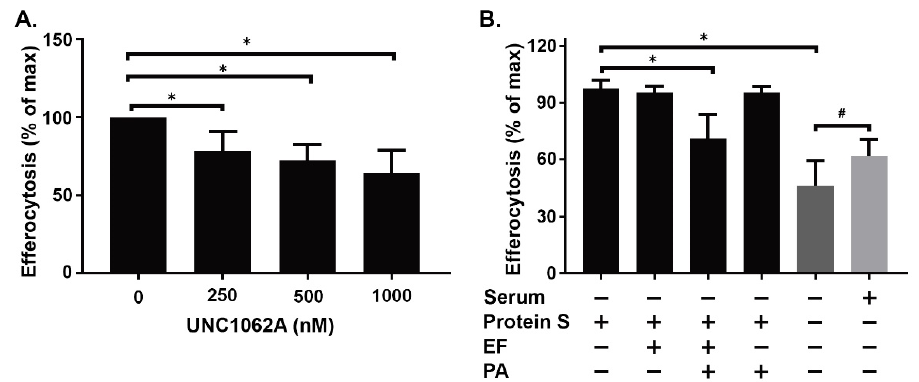
Figure 4. Serum-dependent efferocytosis by M2(Dex) macrophages signals through MerTK and is inhibited by ET. ( A ) The efferocytosis by M2(Dex) macrophages was preincubated for 1 h with various concentrations of the selective MerTK inhibitor UNC1062A and then incubated with apoptotic human PMN in the presence of serum for 1 h; ( B ) The efferocytosis by M2(Dex) macrophages waws preincubated with EF, PA, or ET (PA+EF) or left untreated for 4 h and then incubated with Protein S- or serum-opsonized apoptotic human PMN for 1 h. The percentages of efferocytic CD206 + M2(Dex) macrophages are reported. The data are presented as mean ± SEM of six individual donors and analyzed using one-way ANOVA followed by Dunnet’s multiple comparisons posttest (* p < 0.05) or Student’s t -test (# p < 0.05). The representative flow cytometry gatings for Figure 4A,B are shown in Figures S2 and S3, respectively.